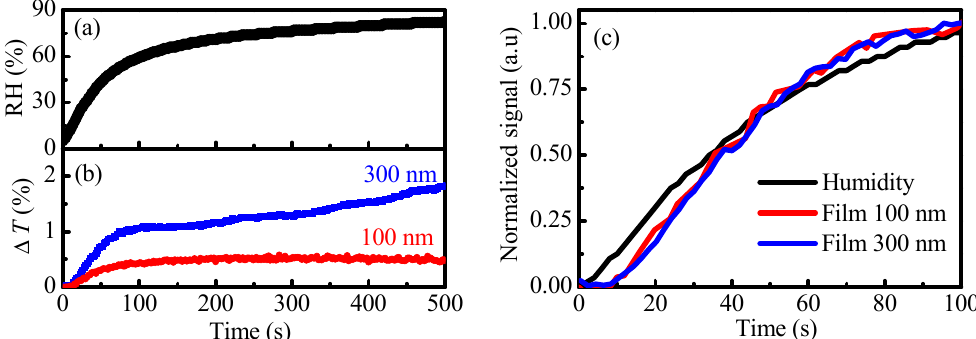
Figure 2. Left: ( a ) Temporal change of the humidity in the cell measured by the reference humidity sensor; ( b ) temporal change of transmittance of thin polymer films with denoted thicknesses deposited on glass substrates when humidity changes gradually from 5% RH to 80% RH; Right: ( c ) Normalized signal for temporal changes of humidity and transmittance of polymer films with thicknesses of 100 and 300 nm.